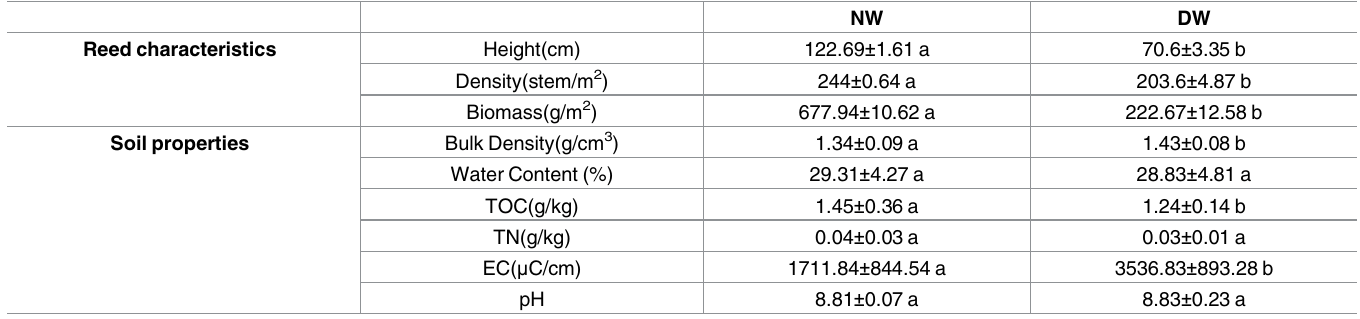
Table 1. Reed characteristics and soil properties in natural and degraded reed